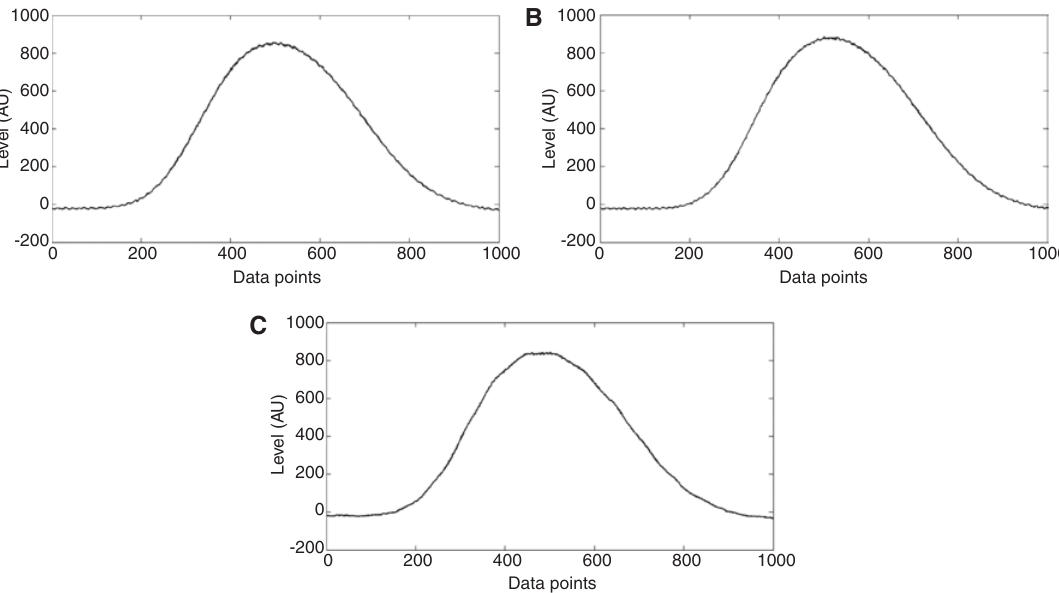
Figure 6: Spectrum of the 1-mm-long FBG sensor: (A) before the fatigue experiment has started, (B) at 3 × 10 6 cycles, and (C) at nearly 4 × 10 6 cycles.